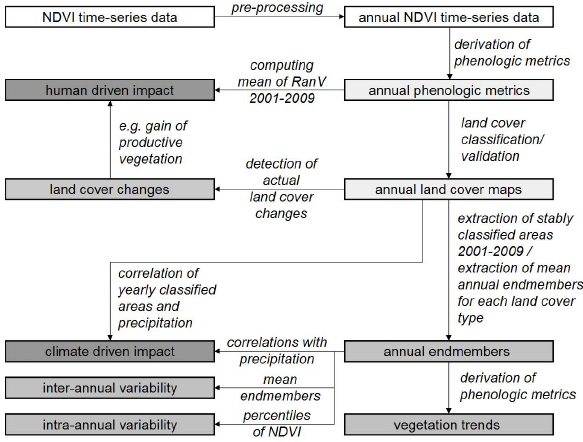
Fig. 1. Workflow. Background colours define working steps as de- fined in the objectives. Light grey indicates results of step 1, grey indicates results of step 2 and dark grey indicates results of step 3.